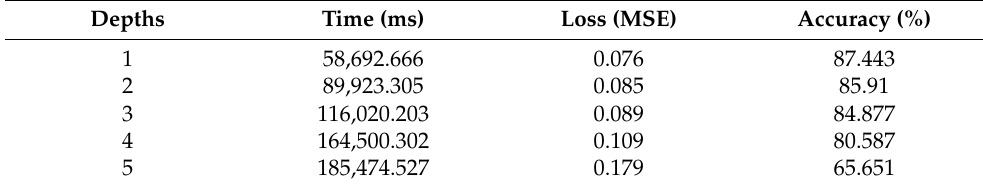
Table 5. Performance table of the evaluation model according to the depth of the hidden